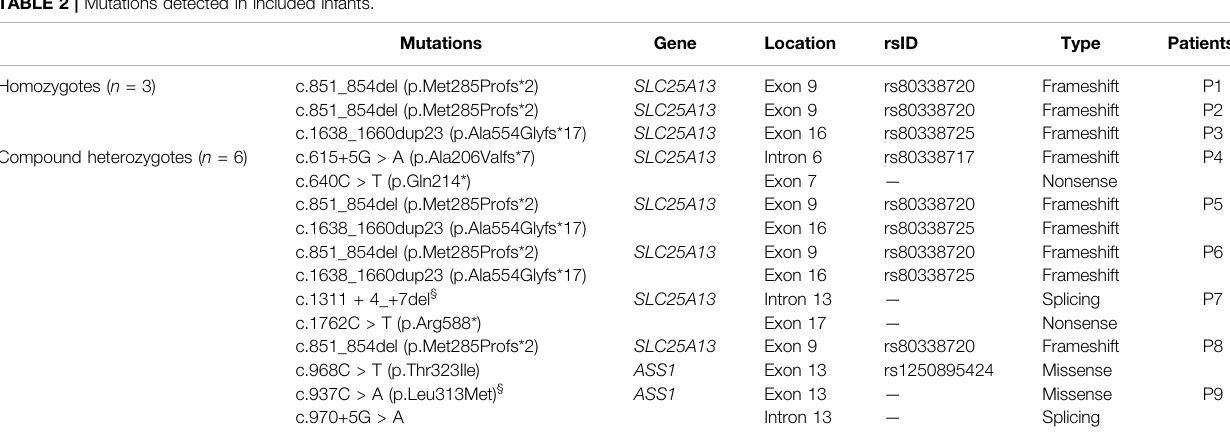
TABLE 2 | Mutations detected in included infants.